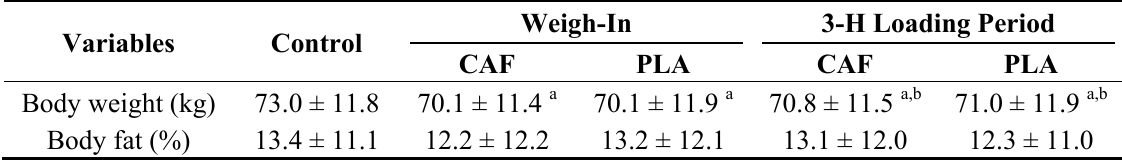
Table 2. Anthropometric data from athletes during control, post-weight loss (weigh-in), and loading period for caffeine (CAF) and placebo (PLA) treatments.